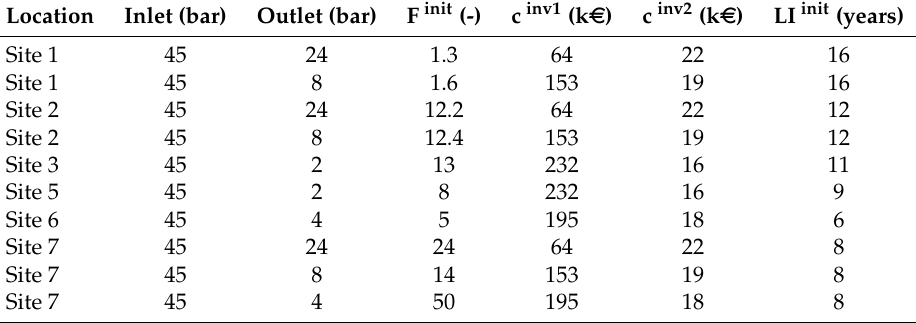
Table 2. Existing steam network turbines and their investment parameters.